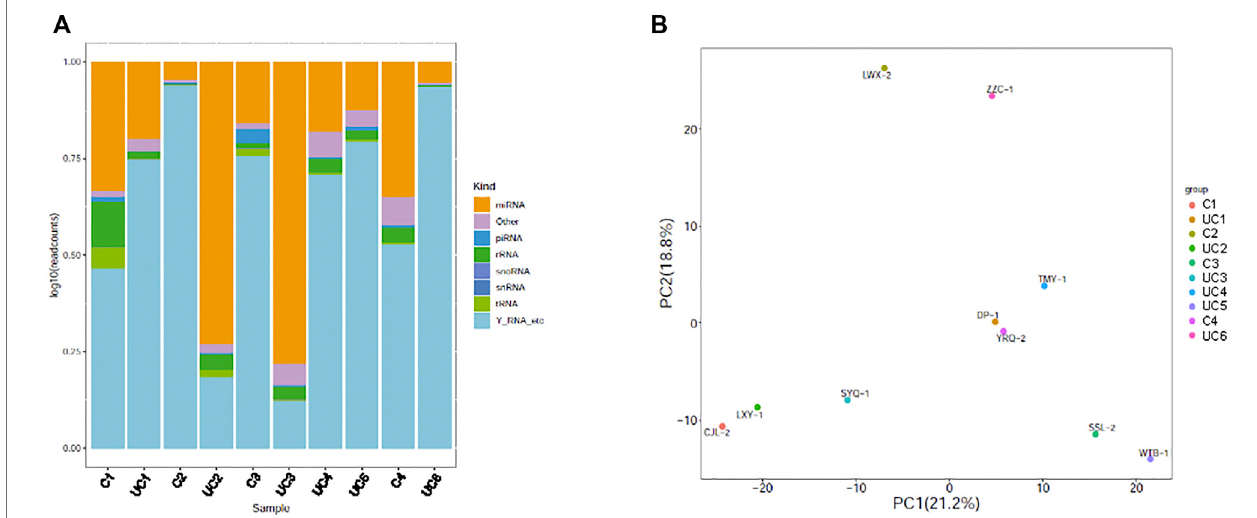
FIGURE 1 | Genome-wide survey of human small RNAs in plasma exosomes. (A) Stacked bar charts showing relative distribution of sequencing reads corresponding to 8 types of non-coding RNAs. (B) Principal component analysis (PCA) plot showing the fi rst two principal components using normalized read counts. Each dot indicates a sample. C = control; UC = ulcerative colitis.